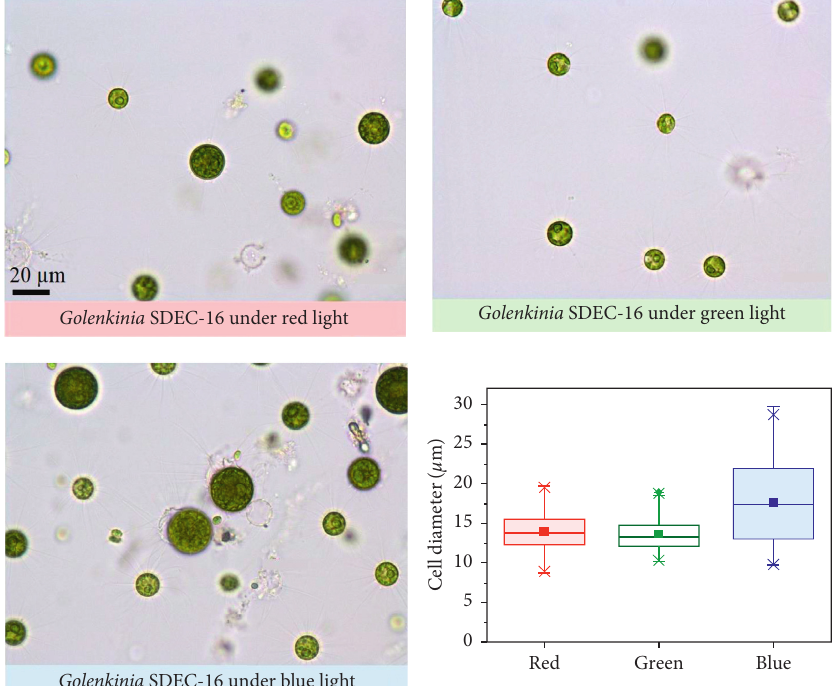
Figure 5: Cell sizes of Golenkinia SDEC-16 grown under three